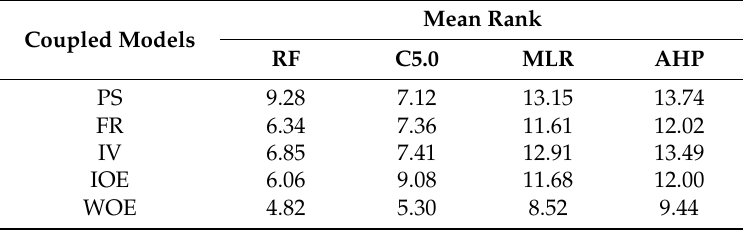
Table 6. Mean rank of di ff erent connection methods under di ff erent data-based